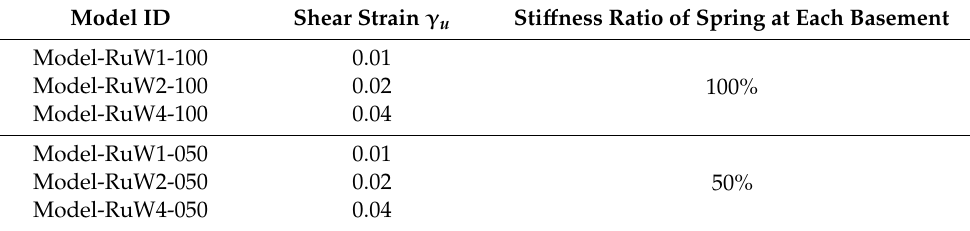
Figure 24. Parameters considered in modeling: ( a ) the force-deformation of the diagonal braces for concrete wall, and ( b ) the stiffness of the vertical and rotational springs at each basement. Table 1. List of structural models considered in the parametric study.